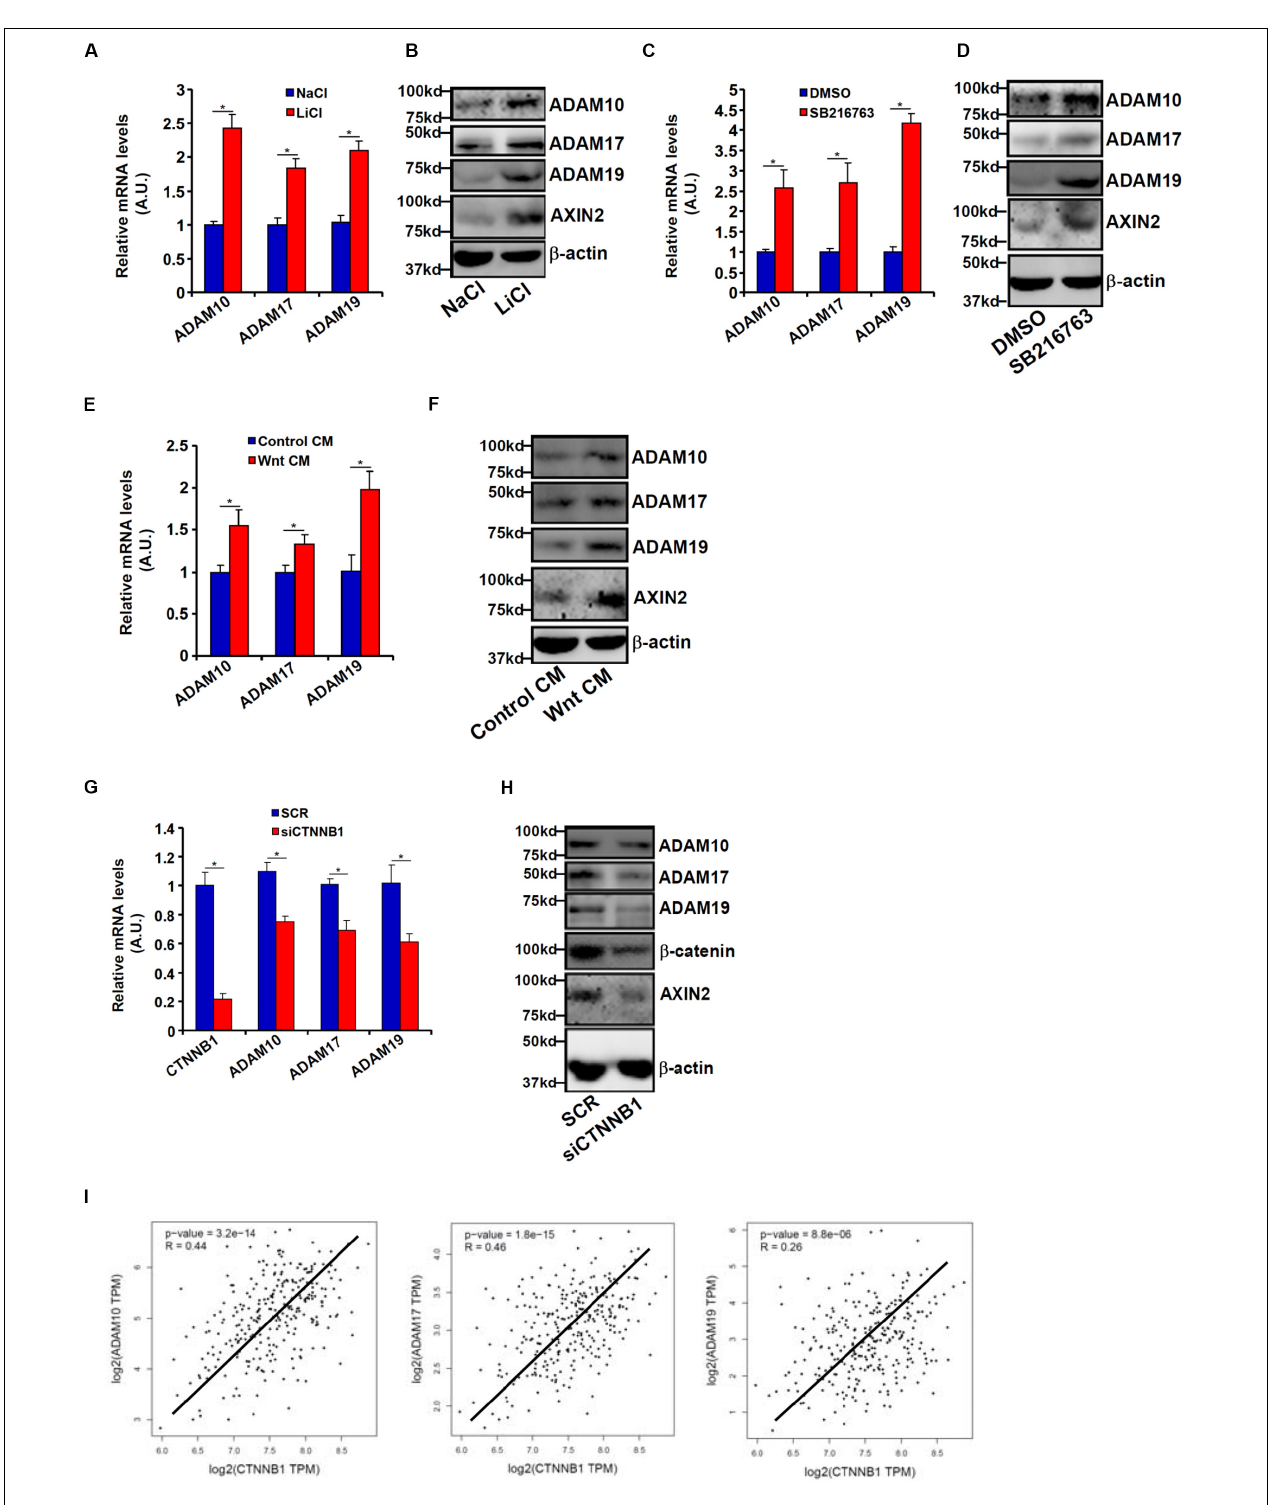
FIGURE 3 | Wnt/ β -catenin signaling regulates ADAM transcription. (A,B) HCT116 cells were treated with LiCl or NaCl for 8 h. ADAM expression levels were examined by qPCR and Western. (C,D) HCT116 cells were treated with SB216763 or dimethyl sulfoxide for 8 h. ADAM expression levels were examined by qPCR and Western. (E,F) HCT116 cells were treated with Wnt-containing CM or a control CM for 8 h. ADAM expression levels were examined by qPCR and Western. (G,H) SW480 cells were transfected with siRNA targeting β -catenin or scrambled siRNA (SCR). ADAM expression levels were examined by qPCR and Western. (I) Correlation between β -catenin expression and ADAM expression in CRC patients. Data represent averages of three independent experiments, and error bars represent SEM ( p < 0.05, two-tailed Student t test).